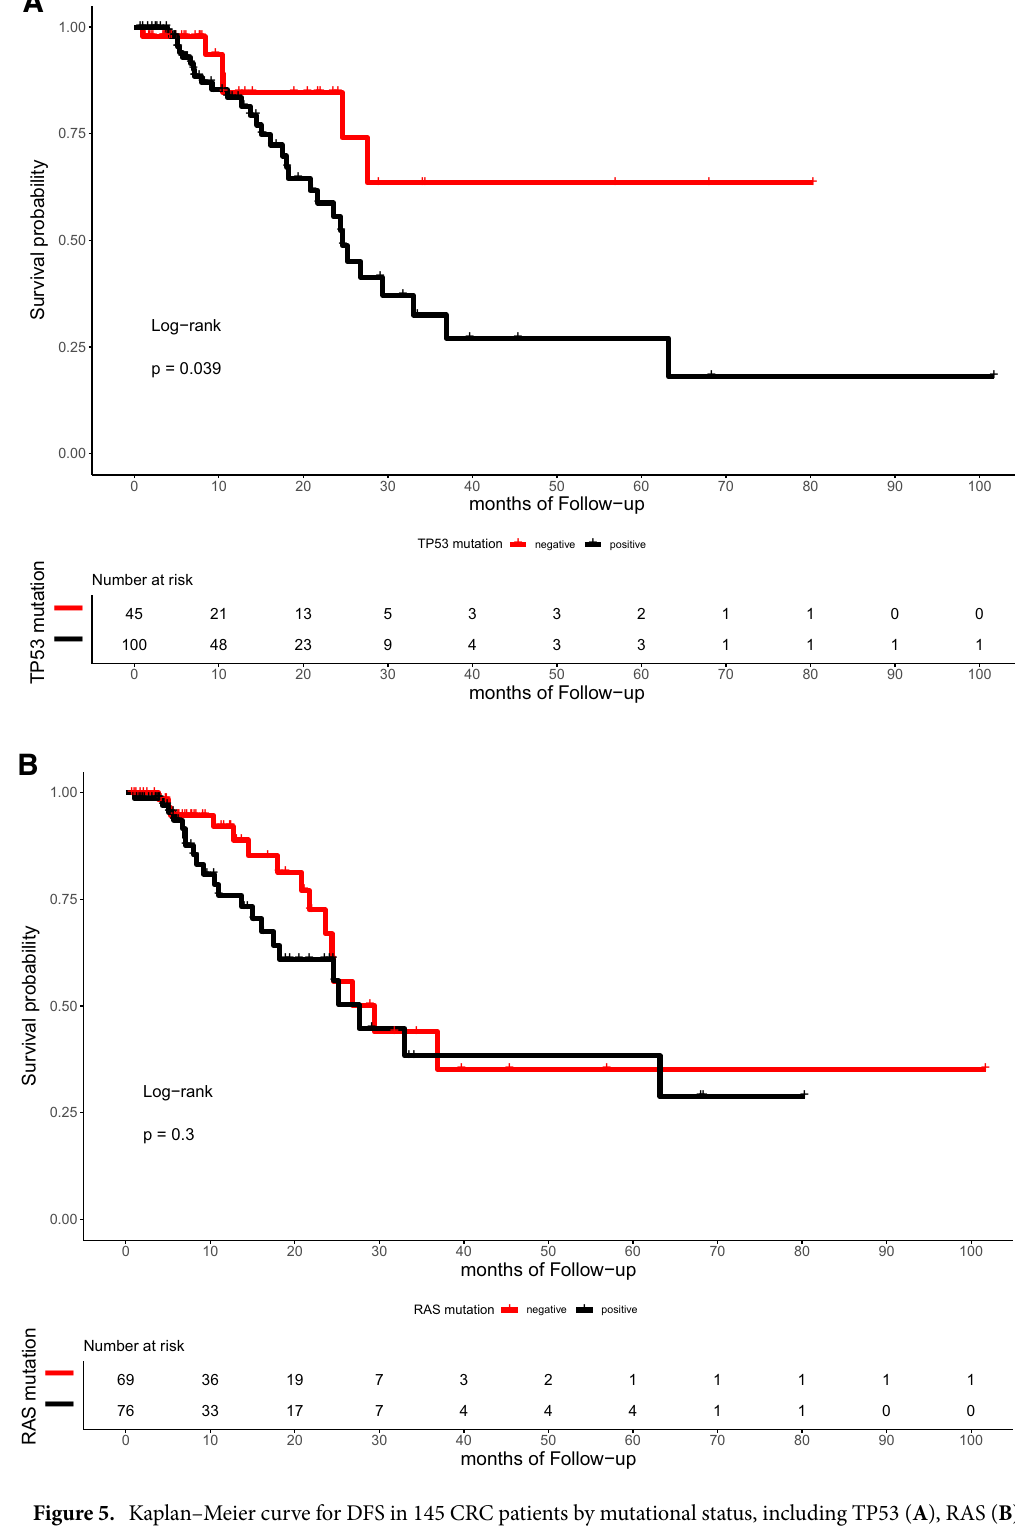
Figure 5. Kaplan–Meier curve for DFS in 145 CRC patients by mutational status, including TP53 ( A ), RAS ( B ), APC ( C ), PIK3CA ( D ), SMAD4 ( E ), BRAF ( F ), ATM ( G ), and FBXW7 ( H